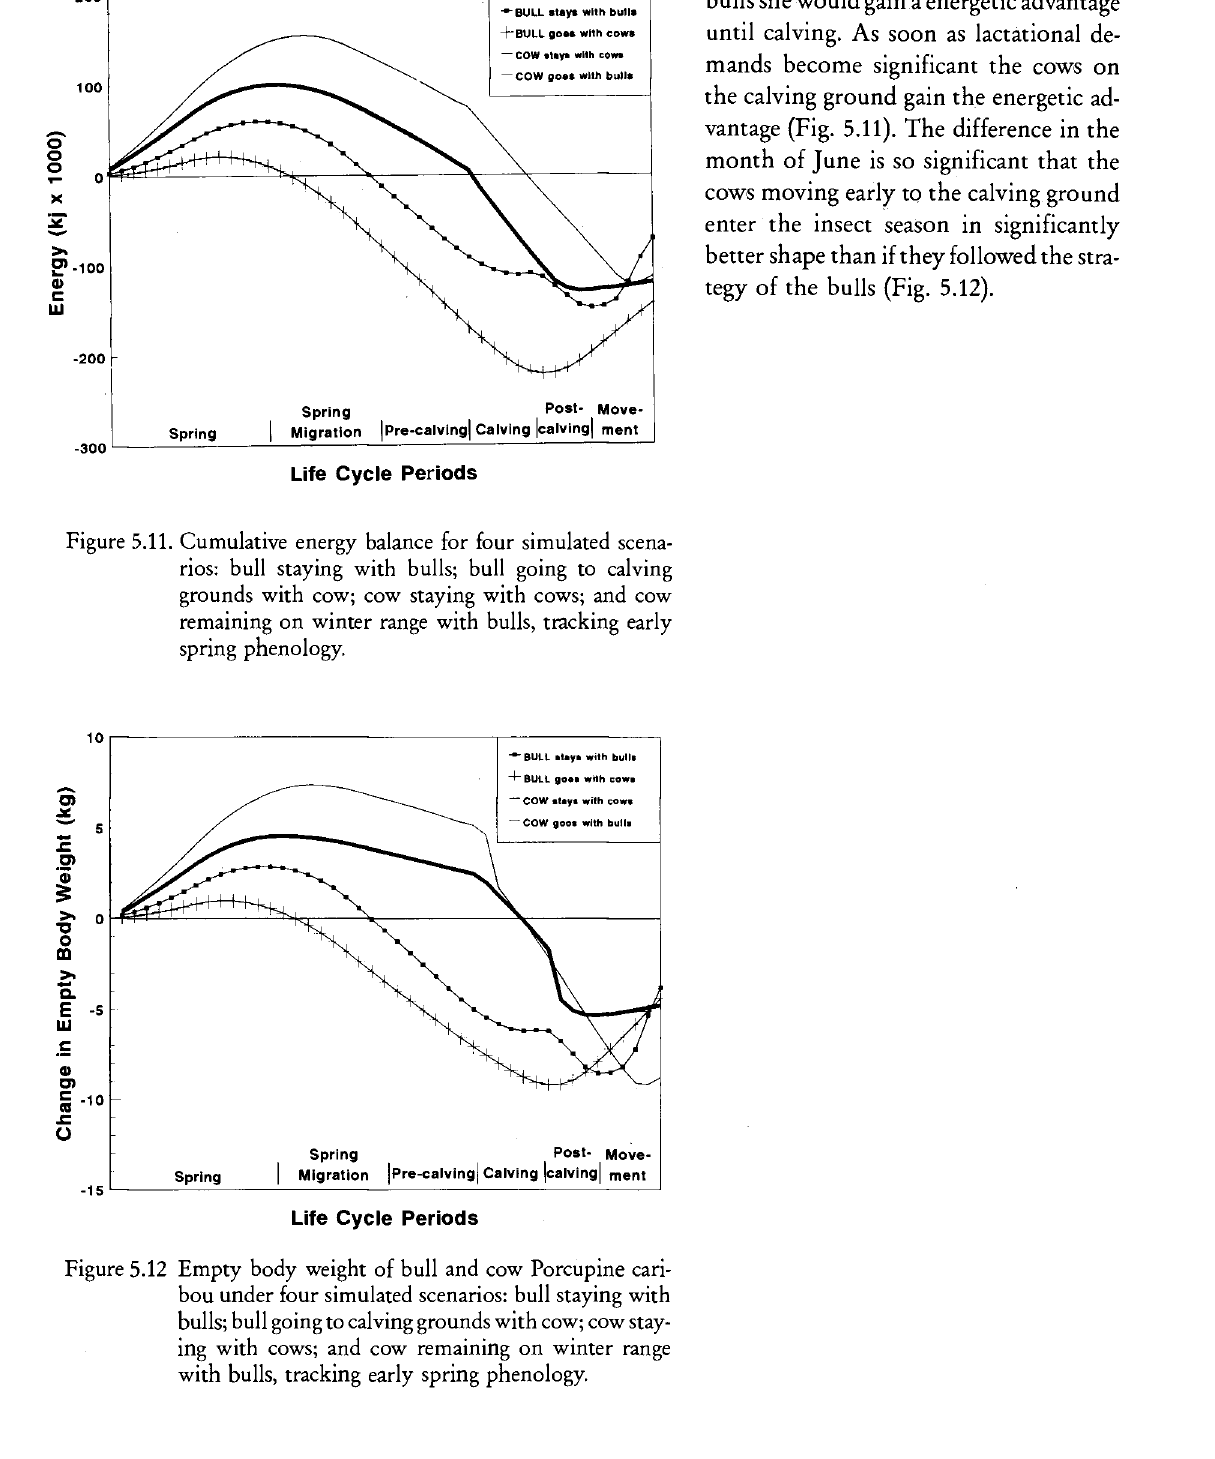
Figure 5.12 Empty body weight of bull and cow Porcupine cari bou under four simulated scenarios: bull staying with bulls; bull going to calving grounds with cow; cow stay ing with cows; and cow remaining on winter range with bulls, tracking early spring